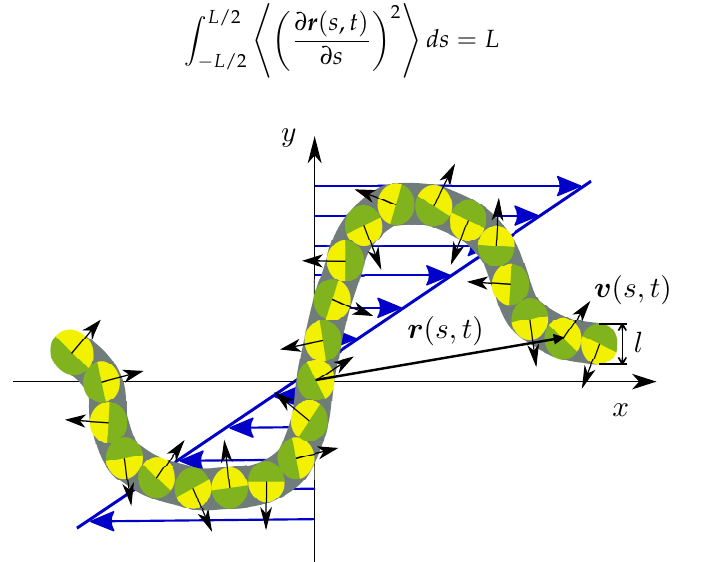
Figure 1. Illustration of the continuous semiflexible active polymer (ABPO) in shear flow. The arrows and colors indicate the orientation of the active velocity v ( s , t )